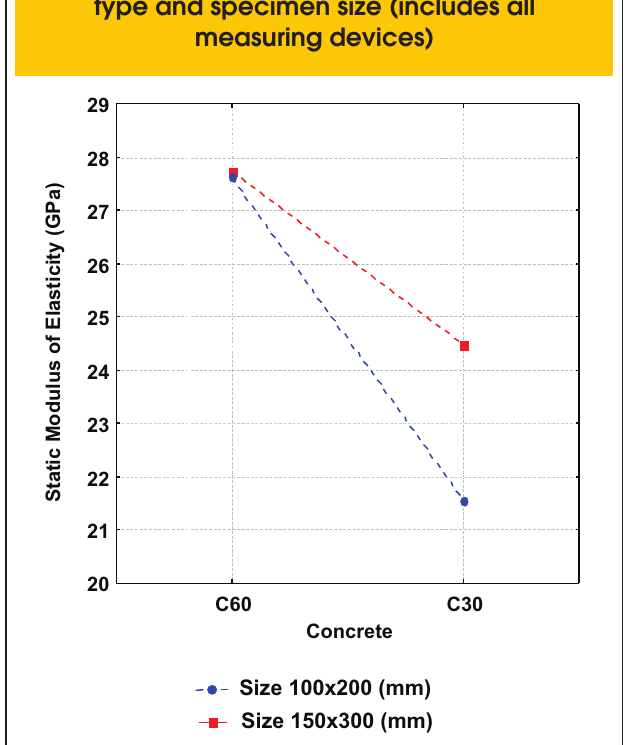
Figure 7 – Modulus of elasticity versus concrete type and specimen size (includes all measuring devices)